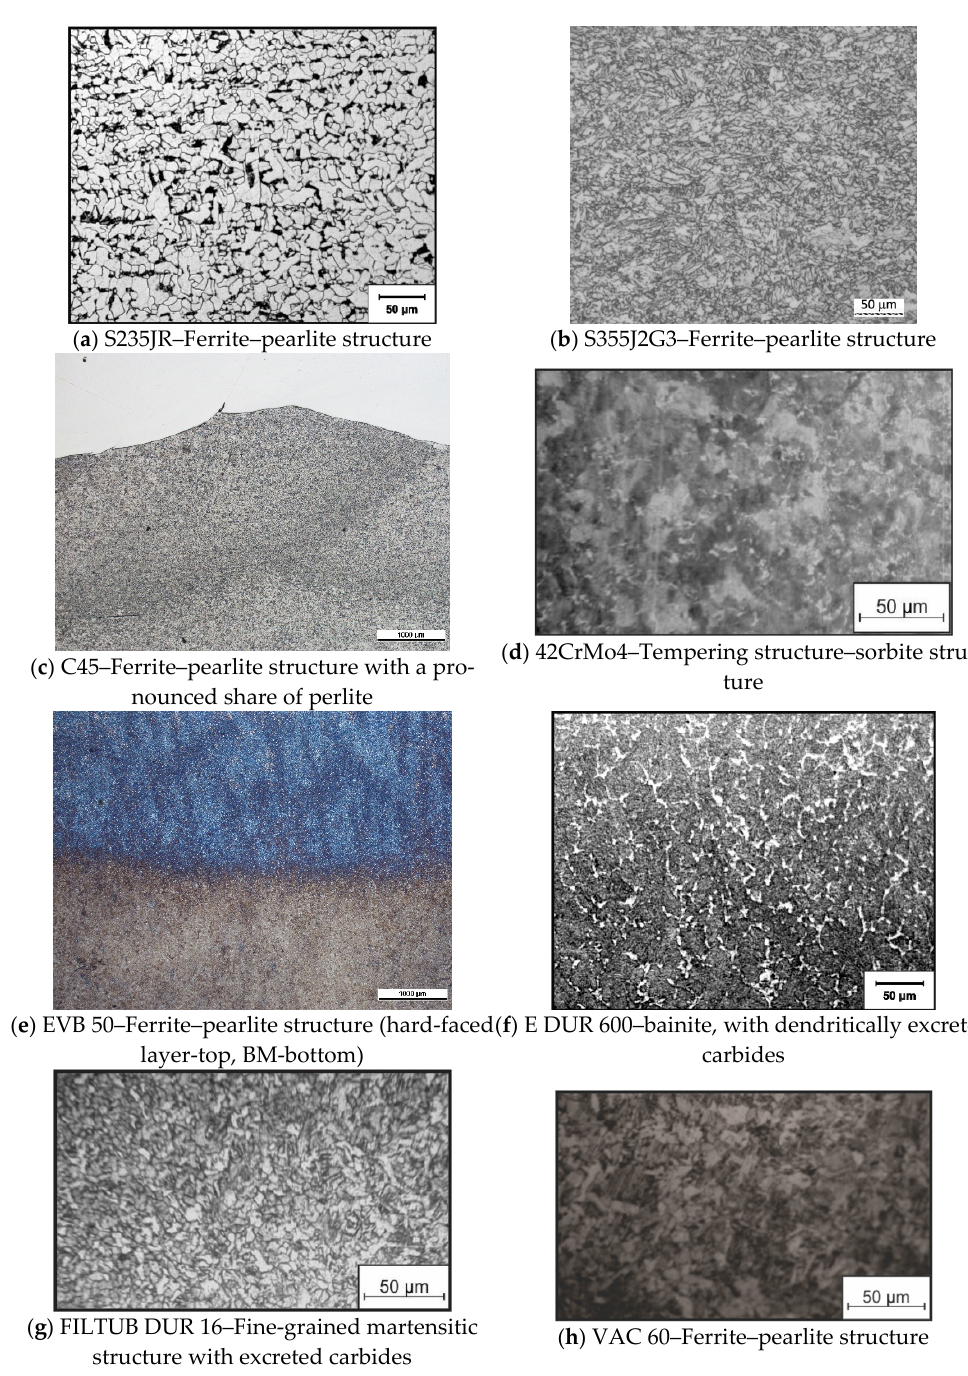
Figure 8. Microstructure in hard-faced layer characteristic zones: base metals ( a – d ); hard-faced layers ( e – h ).